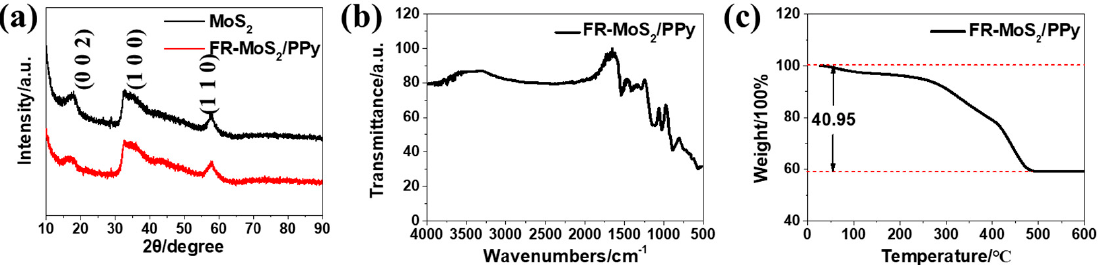
Figure 1. ( a ) XRD patterns of MoS 2 and FR-MoS 2 /PPy, ( b ) FT-IR spectra, and ( c ) TGA curve of FR-MoS 2 /PPy.